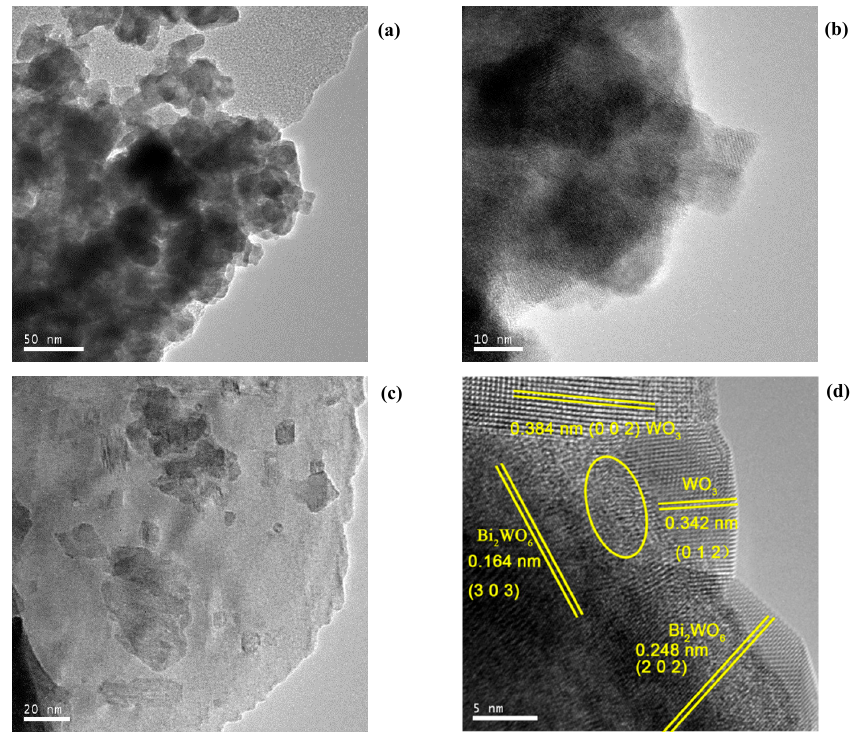
Figure 5. TEM images of ( a , b ) parent and ( c , d ) photohydrothermally treated Bi 2 WO 6 /WO 3 (natural light, CR = 600, 5 h).